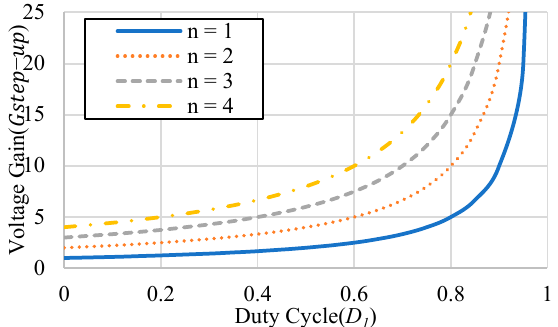
Figure 7. Relationship between the voltage gain and the duty cycle in the step-up mode.